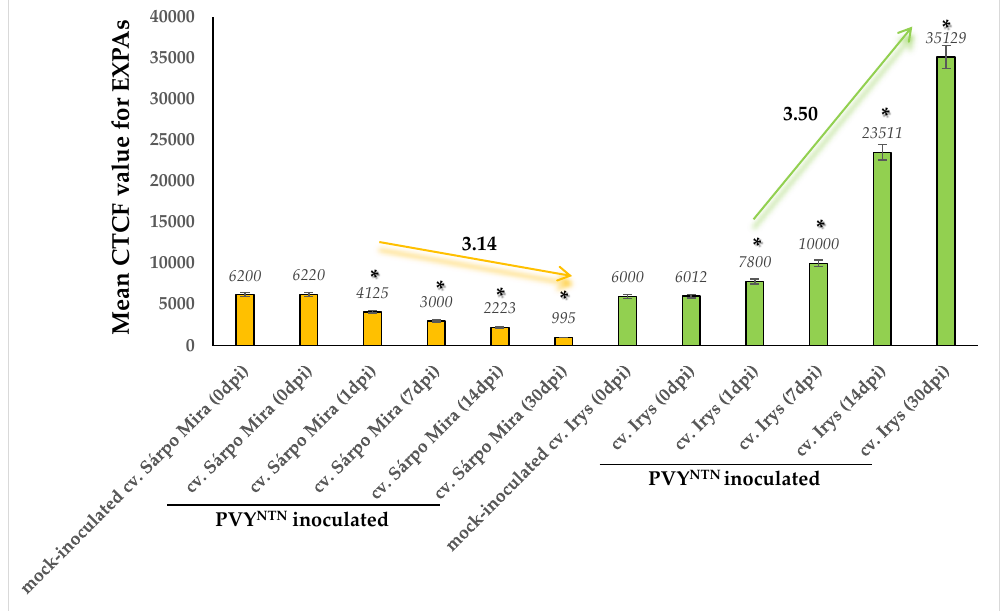
Figure 3. Quantitative fluorescence signals of StEXPAs using the corrected total cell fluorescence method (CTCF) in combination with ANOVA. The orange charts represent mock-inoculated and PVY-inoculated cv. S á rpo Mira (resistant) potato plants at 0, 1, 7, 14, and 30 dpi. The orange arrow represents a decrease in the fluorescent signal value between 1 and 30 dpi in virus-infected S á rpo Mira plants. The light green charts represent mock-inoculated and PVY NTN -inoculated cv. Irys (susceptible). The light green arrow represents an increase in the fluorescent signal value between 1 and 30 dpi in virus-infected cv. Irys plants. The mean values of CTCF were evaluated at the p < 0.05 level of significance using a post-hoc Tukey HSD test. Statistically significant values on di ff erent days after mock or viral inoculation for the cultivars are marked by asterisks (*) above the mean value of the CTCF on each chart